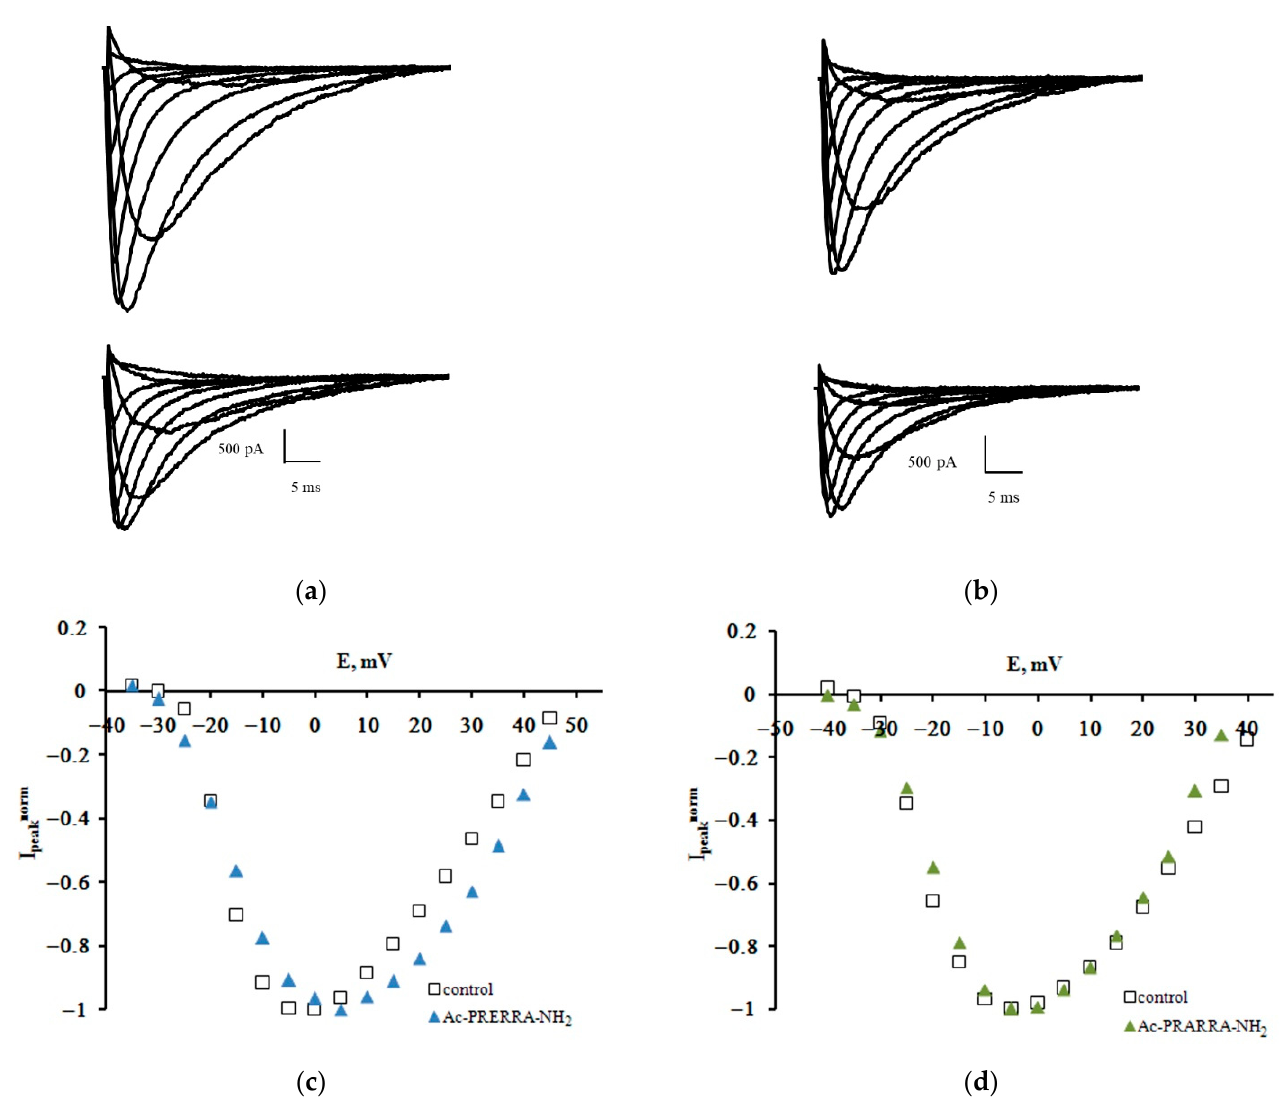
Figure 1. Ac-PRERRA-NH 2 and Ac-PRARRA-NH 2 effects on the Na V 1.8 channel. Families of currents recorded before (top) and after (bottom) the extracellular application of Ac-PRERRA-NH 2 ( a ) and Ac-PRARRA-NH 2 ( b ). Normalized peak current–voltage functions of the Na V 1.8 channel in the control experiment and after the application of Ac-PRERRA-NH 2 ( c ) and Ac-PRARRA-NH 2 ( d ). The test potential was changed from − 60 mV to 45 mV with a step of 5 mV. The holding potential of a 300 ms duration was equal to − 110 mV in all records. The leakage and capacitive currents were subtracted automatically.